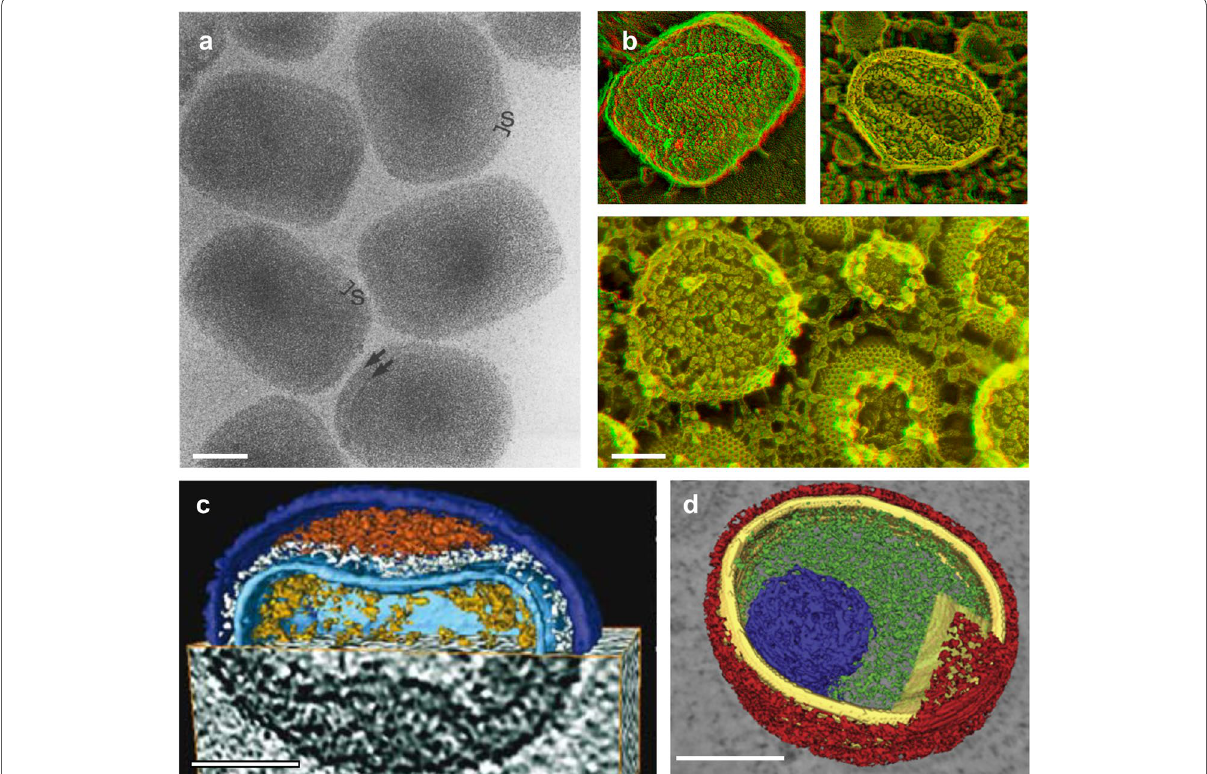
Fig. 3 Morphological studies of VACV in the era of cryogenic 3DEM. a A cryo-electron micrograph of vitrified VACV mature virion showing surface domain (labeled S) and two membrane boundaries (arrows). b 3D deep-etch microscopy images showing external and internal morphologies of mature VACV virion (top row) and characteristic honeycomb-like scaffold of immature virion (bottom row). c Cryo-electron tomogram of mature VACV virion where top half is shown by surface rendering and bottom half by tomographic section. d Surface representation of cryo-electron tomogram of immature VACV virion. Scale bars are 0.1 μm. The images are reprinted with permission, from a Dubochet et al. Journal of Virology, 1994, doi: https:// doi. org/ 10. 1128/ jvi. 68.3. 1935- 1941. 1994, b Heuser, The Journal of Cell Biology, 2005, doi: https:// doi. org/ 10. 1083/ jcb. 20041 2169 and Szajner et al., The Journal of Cell Biology, 2005, doi: https:// doi. org/ 10. 1083/ jcb. 20050 4026, c Cyrklaff et al. PLoS One, 2007, doi: https:// doi. org/ 10. 1371/ journ al. pone. 00004 20, d Chlanda et al. Cell Host & Microbe, 2009, doi: https:// doi. org/ 10. 1016/j. chom. 2009. 05.